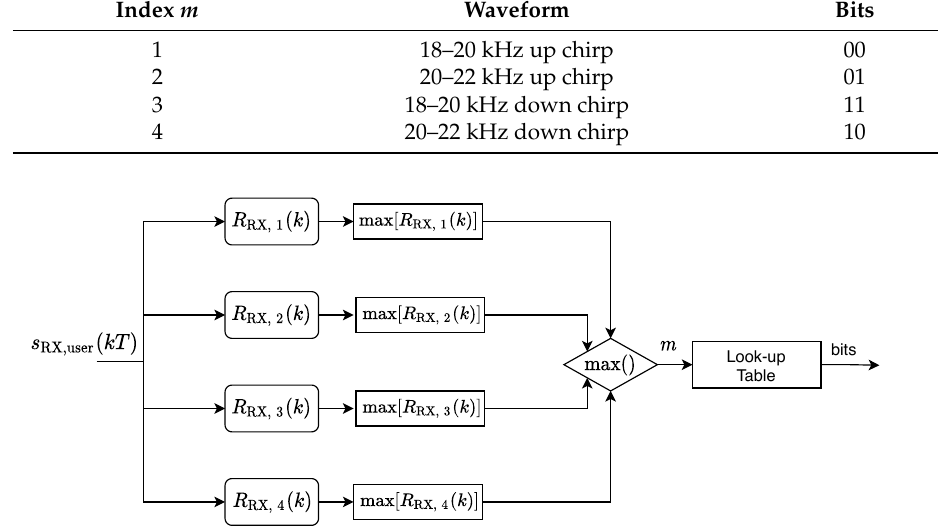
Figure 3. User demodulation